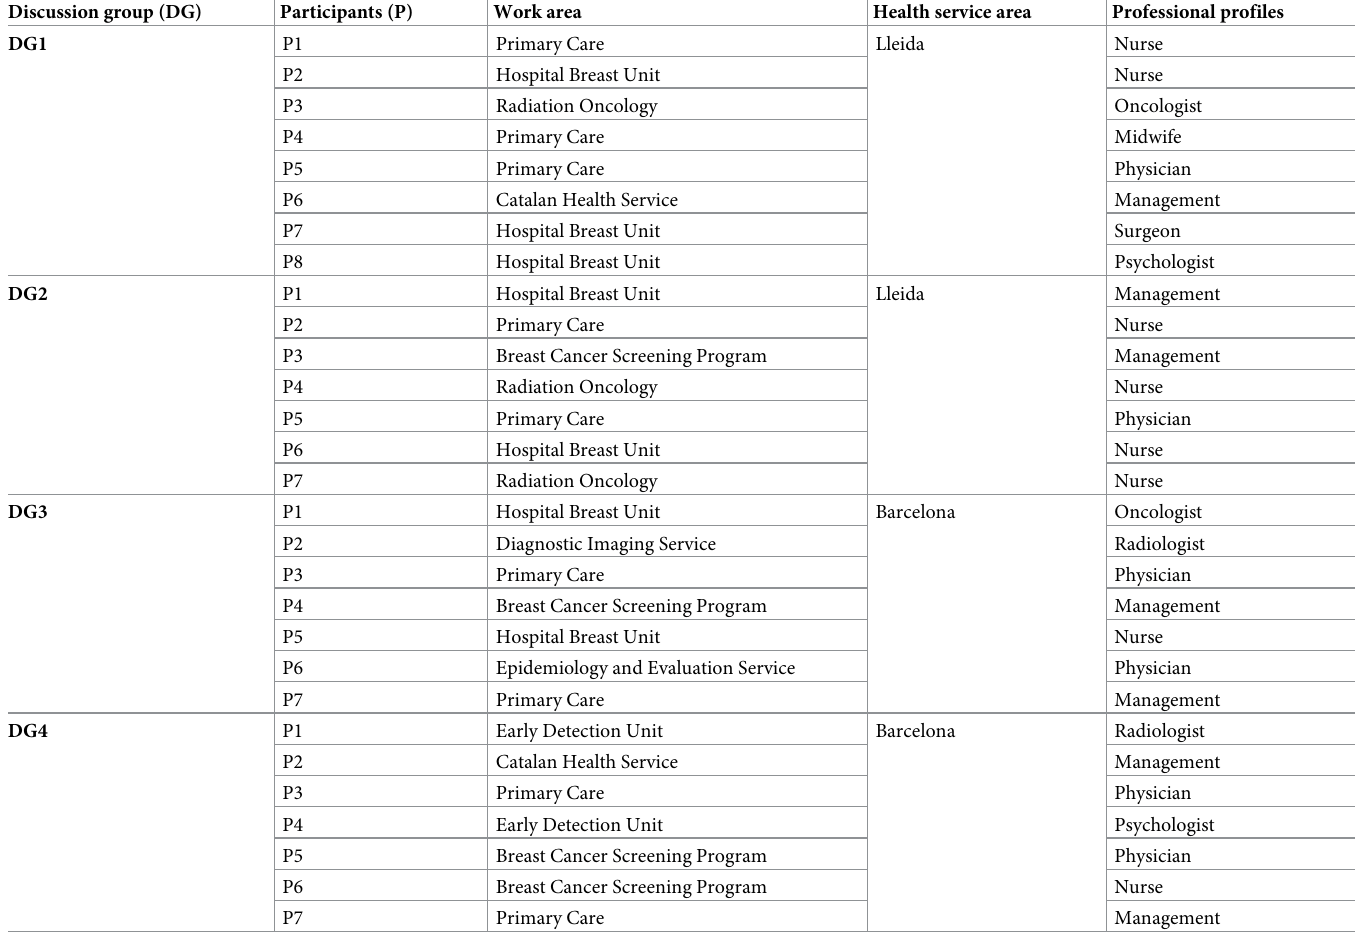
Table 1. Characteristics of the study